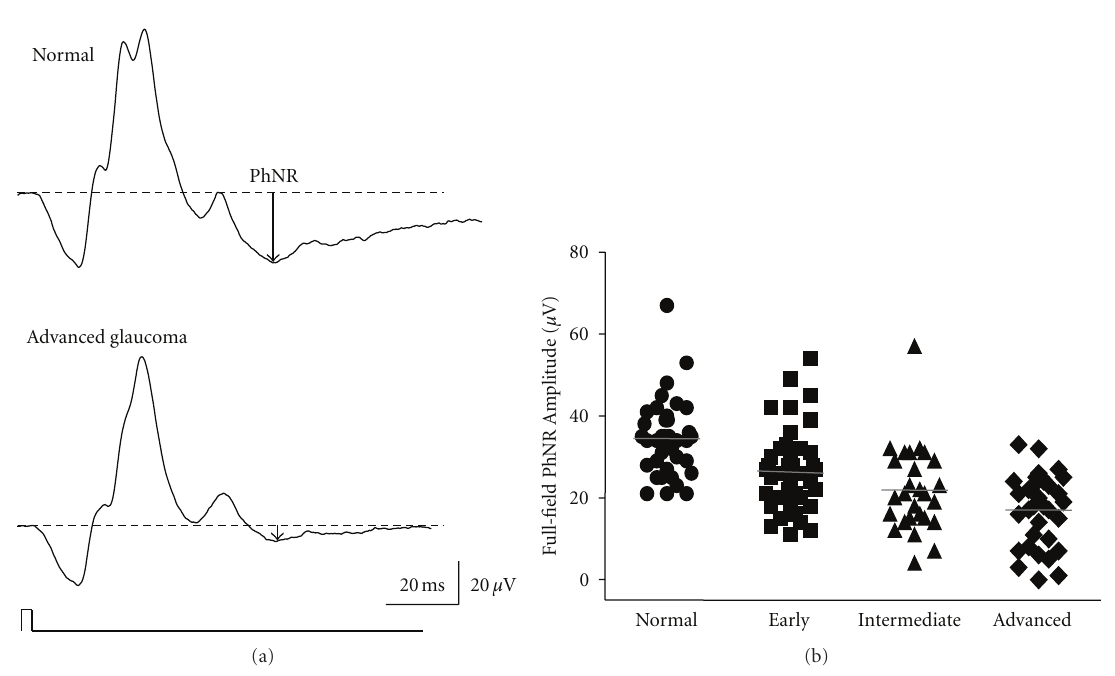
Figure 6: (a) Representative waveforms of the full-field cone electroretinogram recorded from a normal subject and a patient with advanced glaucoma. (b) PhNR amplitudes were plotted for normal subjects ( n = 42) and patients with early ( n = 41), intermediate ( n = 28), and advanced glaucoma ( n = 34). PhNR: photopic negative response (reproduced with permission from [27]).